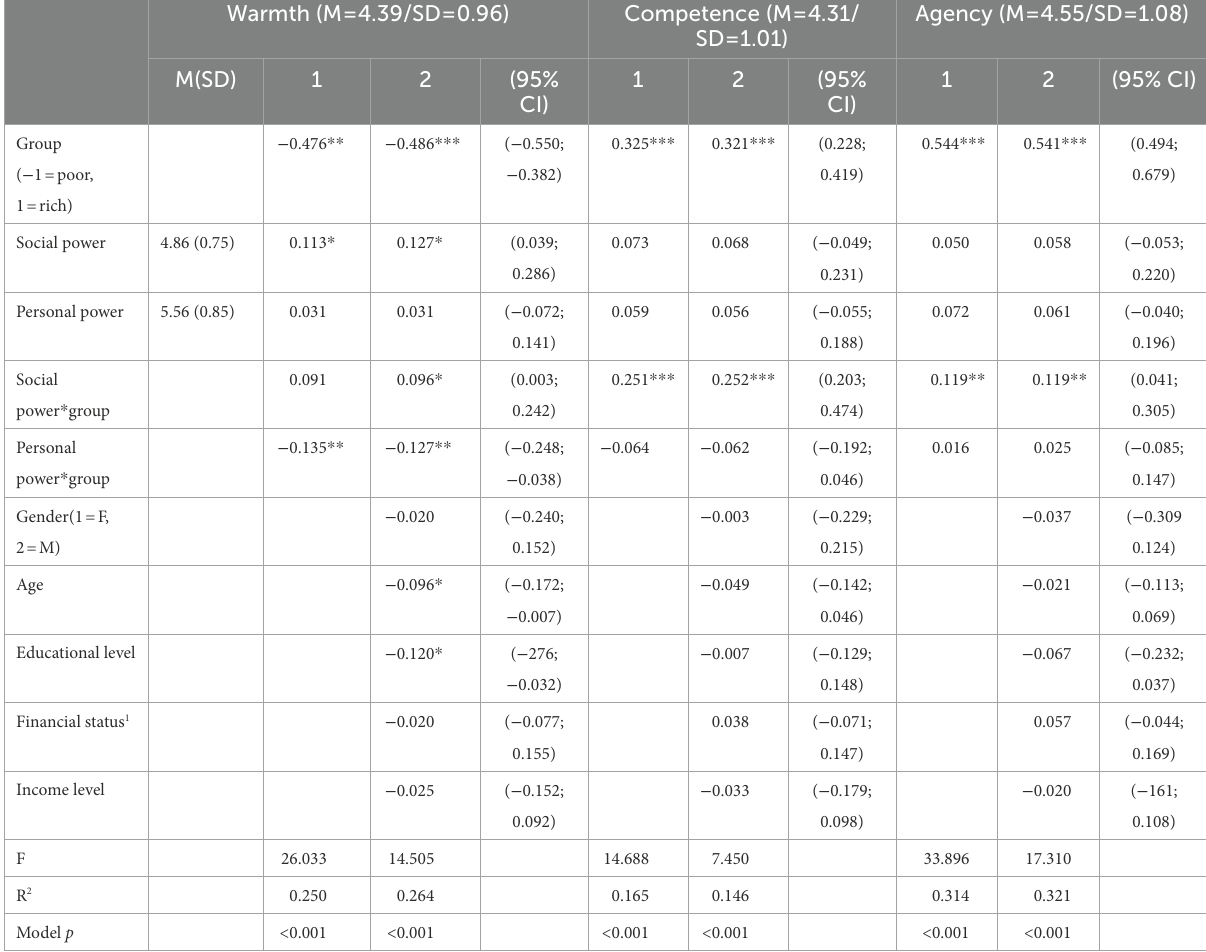
TABLE 1 Regression results—direct and moderated effects on perceptions of warmth, competence, and agency. Warmth (M = 4.39/SD =